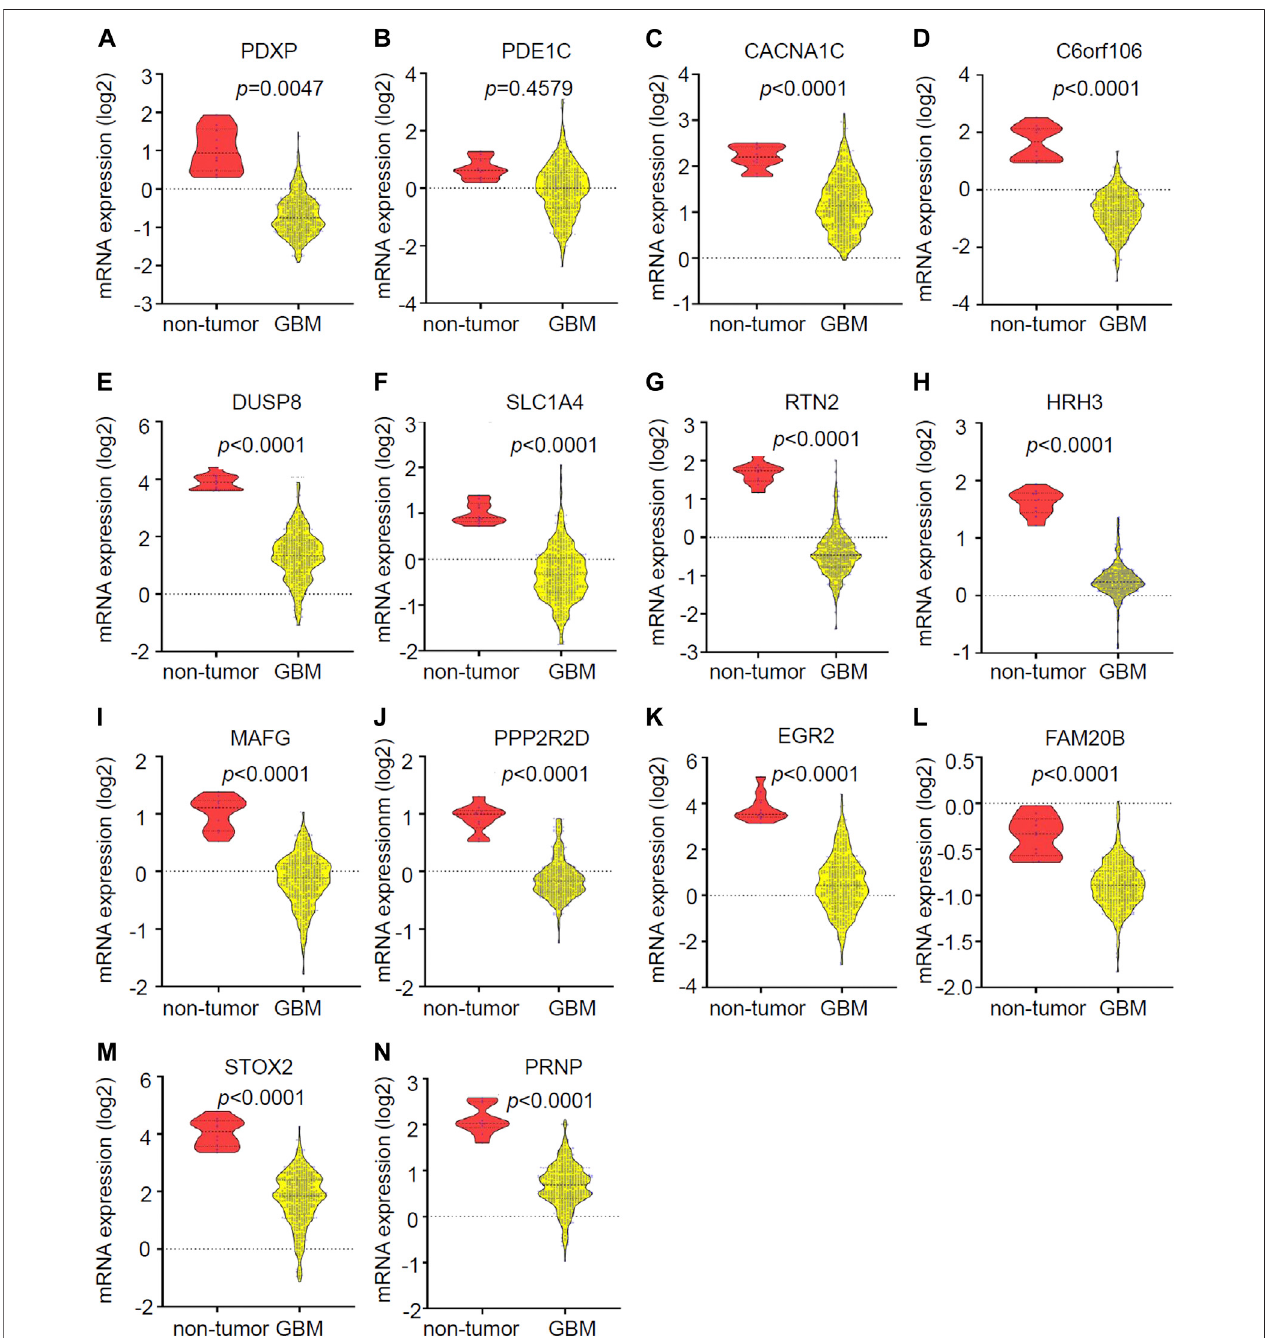
FIGURE 6 | Validation of the expression of 14 potential downregulated genes in GBMs vs. brains. (A – N) Expression of (A) PDXP, (B) PDE1C, (C) CACNA1G, (D) C6orf106, (E) DUSP8, (F) SLC1A4, (G) RTN2, (H) HRH3, (I) MAFG, (J) PPP2R2D, (K) EGR3, (L) FAM20B, (M) STOX2, and (N) PRNP in GBM vs. brain tissues according to the Gliovis database. p -value < 0.05 was considered as statistically signi fi cant.